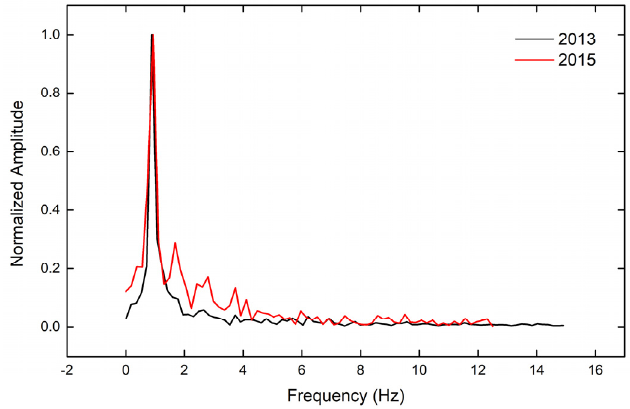
Figure 4. Summary of the computed lateral deflections (axis x) and the spurious longitudinal deflections (axis y) indicating the noise level in the measurements. Differences in the amplitude of displacements in 2013 and 2015 indicate the difference in excitations.